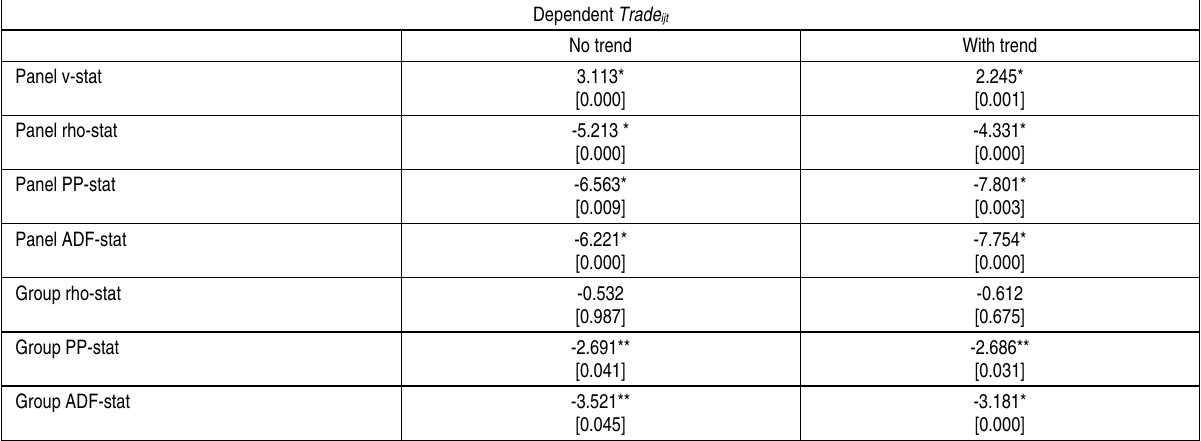
Table 2. Pedroni Cointegration test